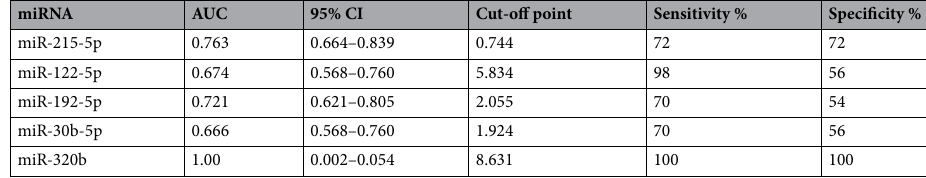
Table 4. Diagnostic performance of the five selected serum miRNAs in discriminating PDAC patients from chronic pancreatitis. *AUC, area under the curve; CI, confidence interval.